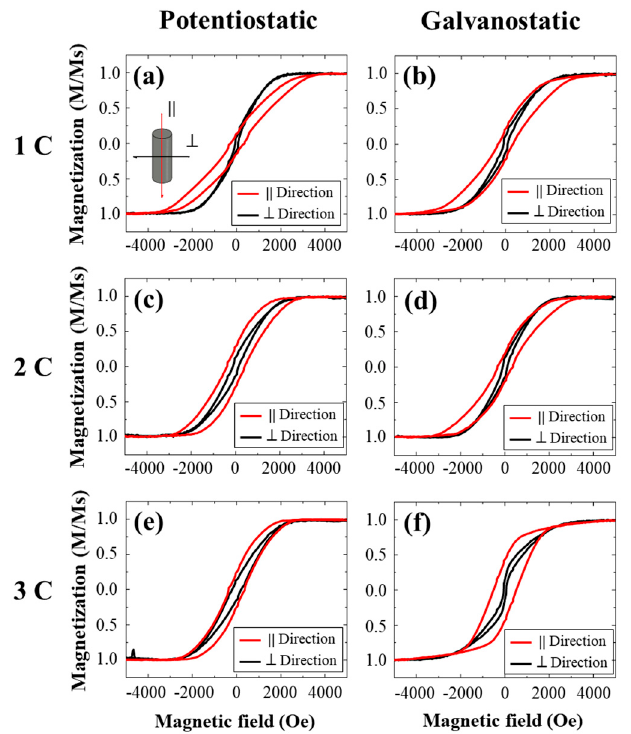
Figure 4. Hysteresis curves of the deposited Ni-Npillars with a parallel alignment external magnetic field (red) and perpendicular alignment (black). Potentiostatic at: ( a ) 1 C, ( c ) 2 C, and ( e ) 3 C. Galvanostatic at: ( b ) 1 C, ( d ) 2 C, and ( f ) 3 C. Table 1. Parallel and perpendicular magnetic properties of Ni-Npillars and their correlation variables. The blanks are either one between the same variable, or the same value with respect to its